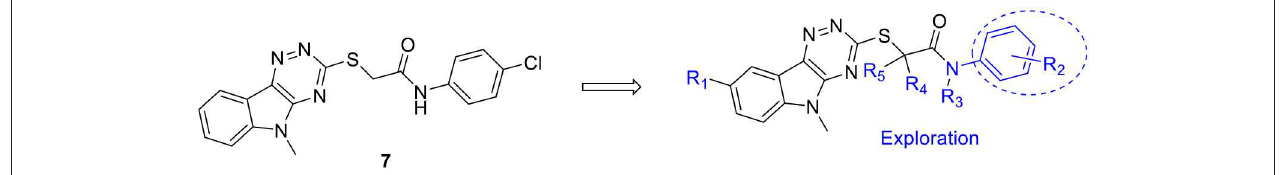
FIGURE 2 | Chemical structure of hit compound 7 and plans for chemical